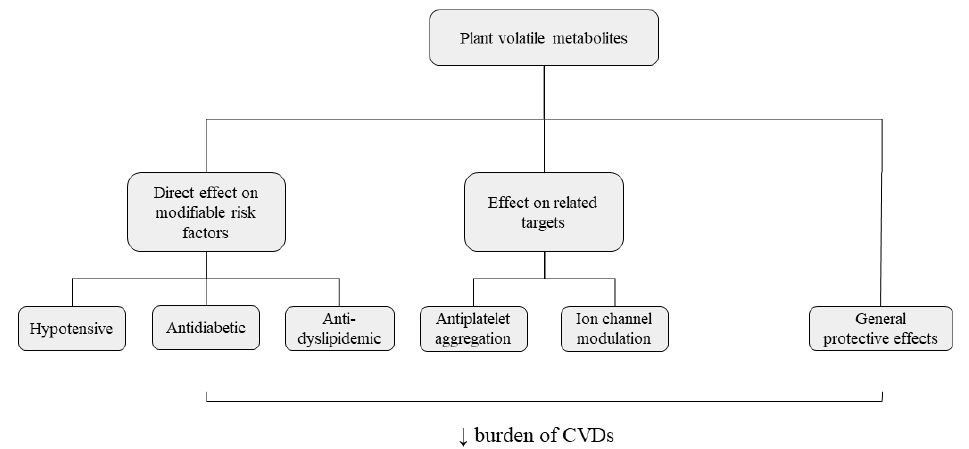
Figure 2. Role of plant volatiles (essential oils and isolated compounds) in the management of cardiovascular disease risk factors and associated targets. cardiovascular disease risk factors and associated